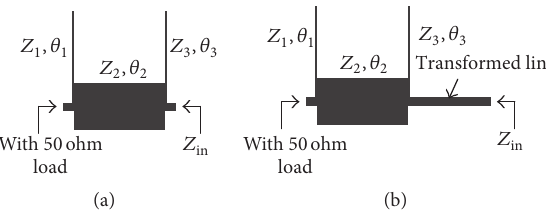
Figure 2: Layout of the BSF: (a) without a transformed line; (b) with a transformed line.